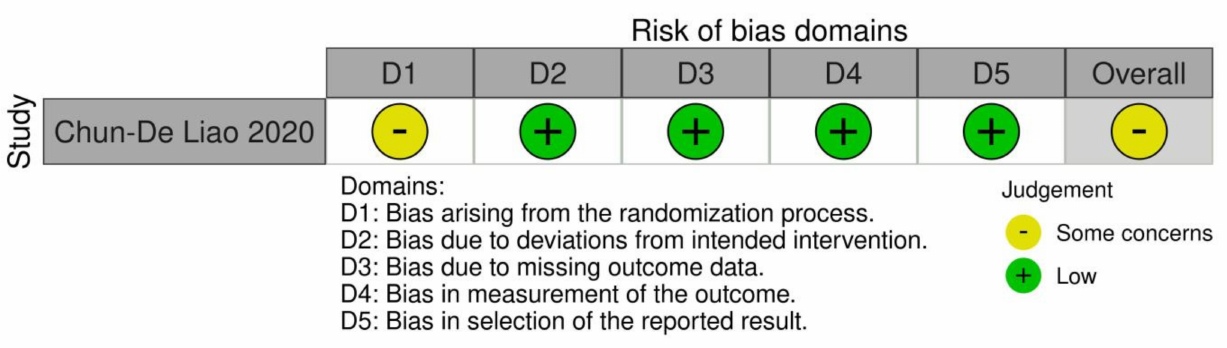
Figure 2. ROB2 assessment of the included study [19].